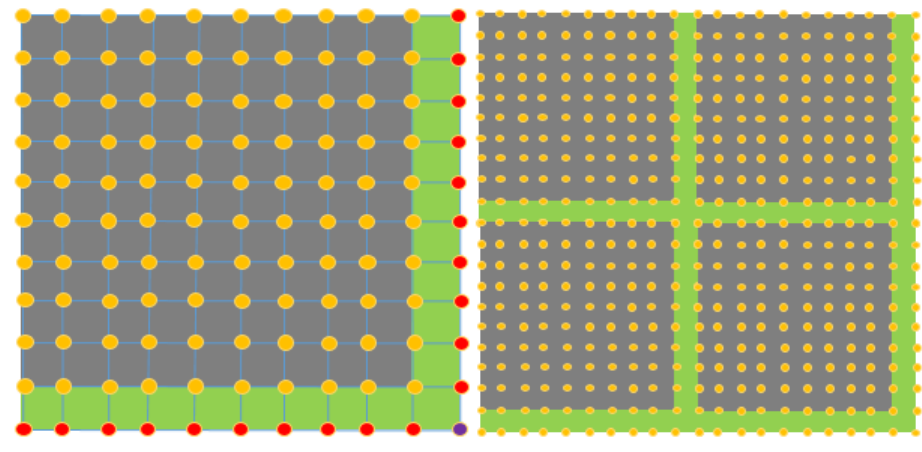
Figure 6. Skirt of missing data between maps.